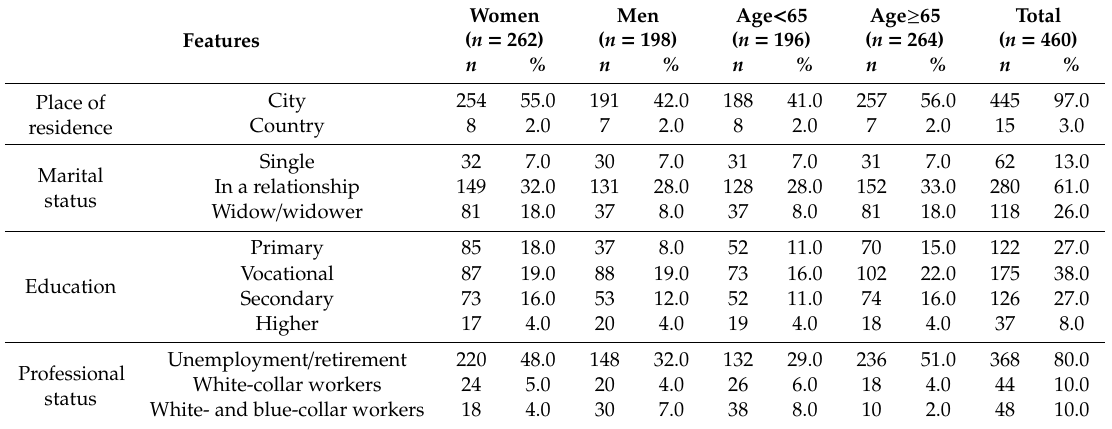
Table 1. Characteristics of the study group, including gender and